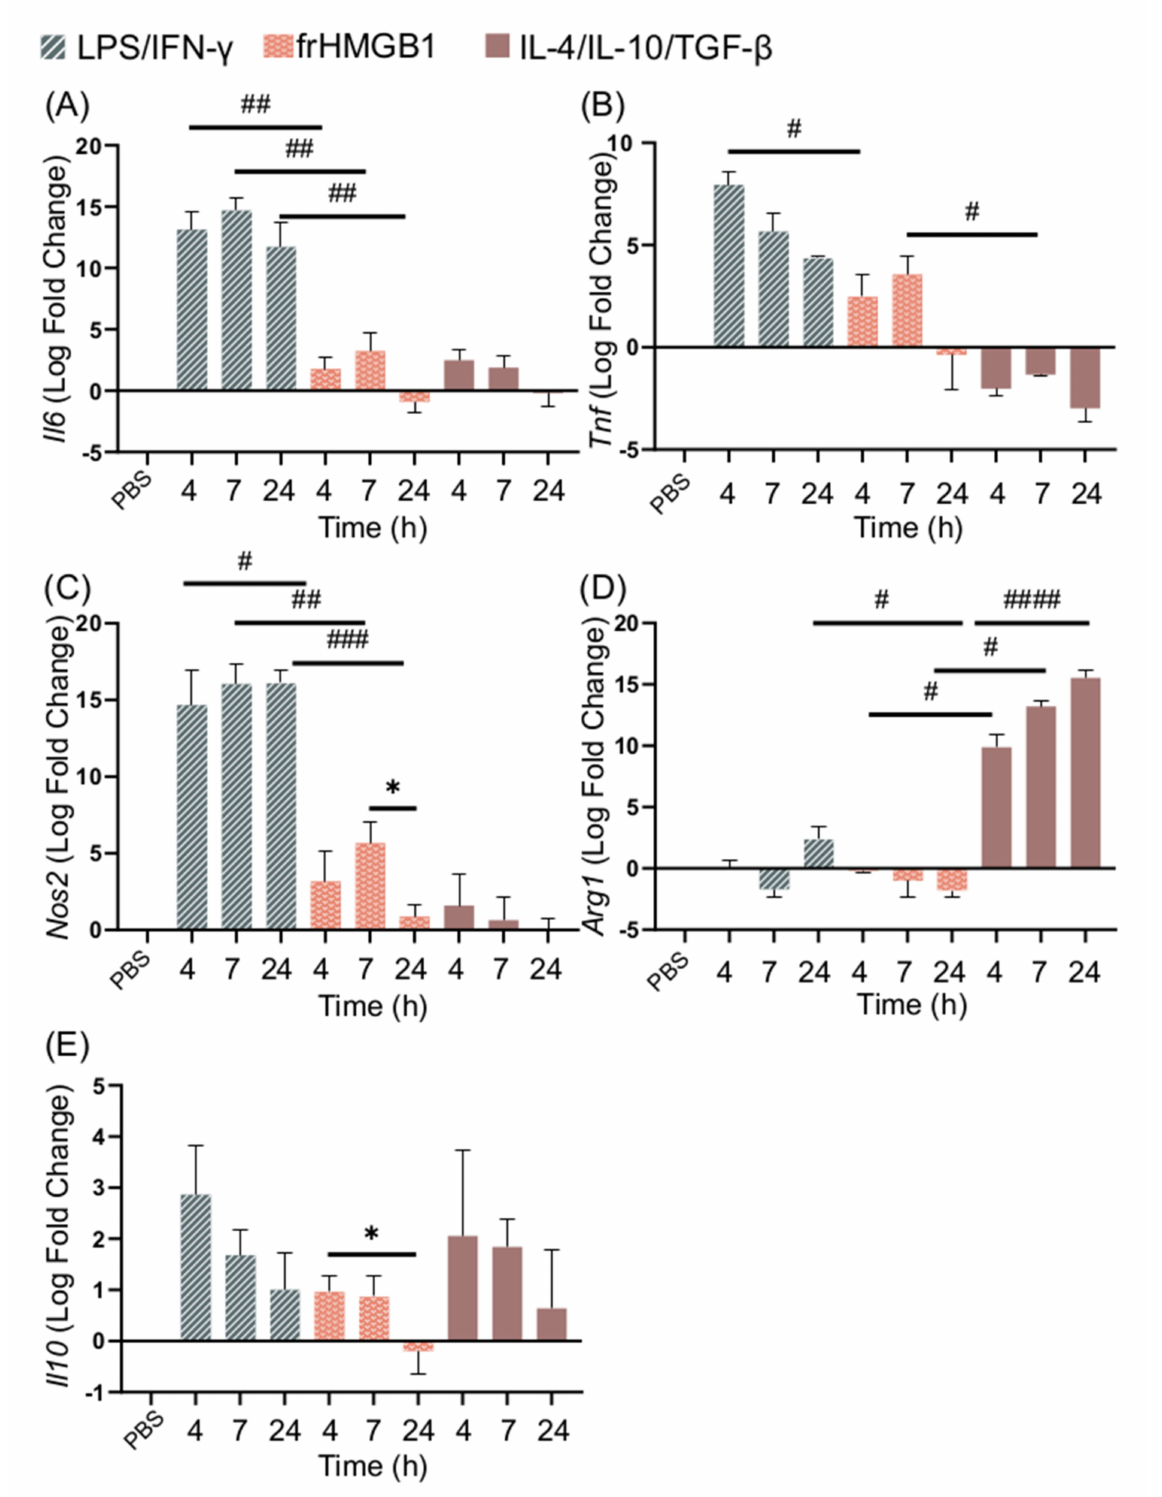
Figure 4. frHMGB1 induces a gene expression pattern that differs from classical M1 and M2 cells. BMDM gene expression of ( A ) Il6 , ( B ) Tnf , ( C ) Nos2 , ( D ) Arg1 , and ( E ) Il10 in response to 5 µ g/mL frHMGB1 at different time points. Groups treated with PBS, LPS/IFN- γ , and IL-4/IL-10/TGF- β were included for comparison. Data represent n = 3. Statistical comparisons were performed using a Brown–Forsythe and a Welch ANOVA with Dunnett’s T3 multiple comparisons test. * represents comparisons for the same treatment between different time points; # represents comparisons between treatments comparing the same time point. */# p ≤ 0.05, ## p ≤ 0.01, ### p ≤ 0.001, #### p <